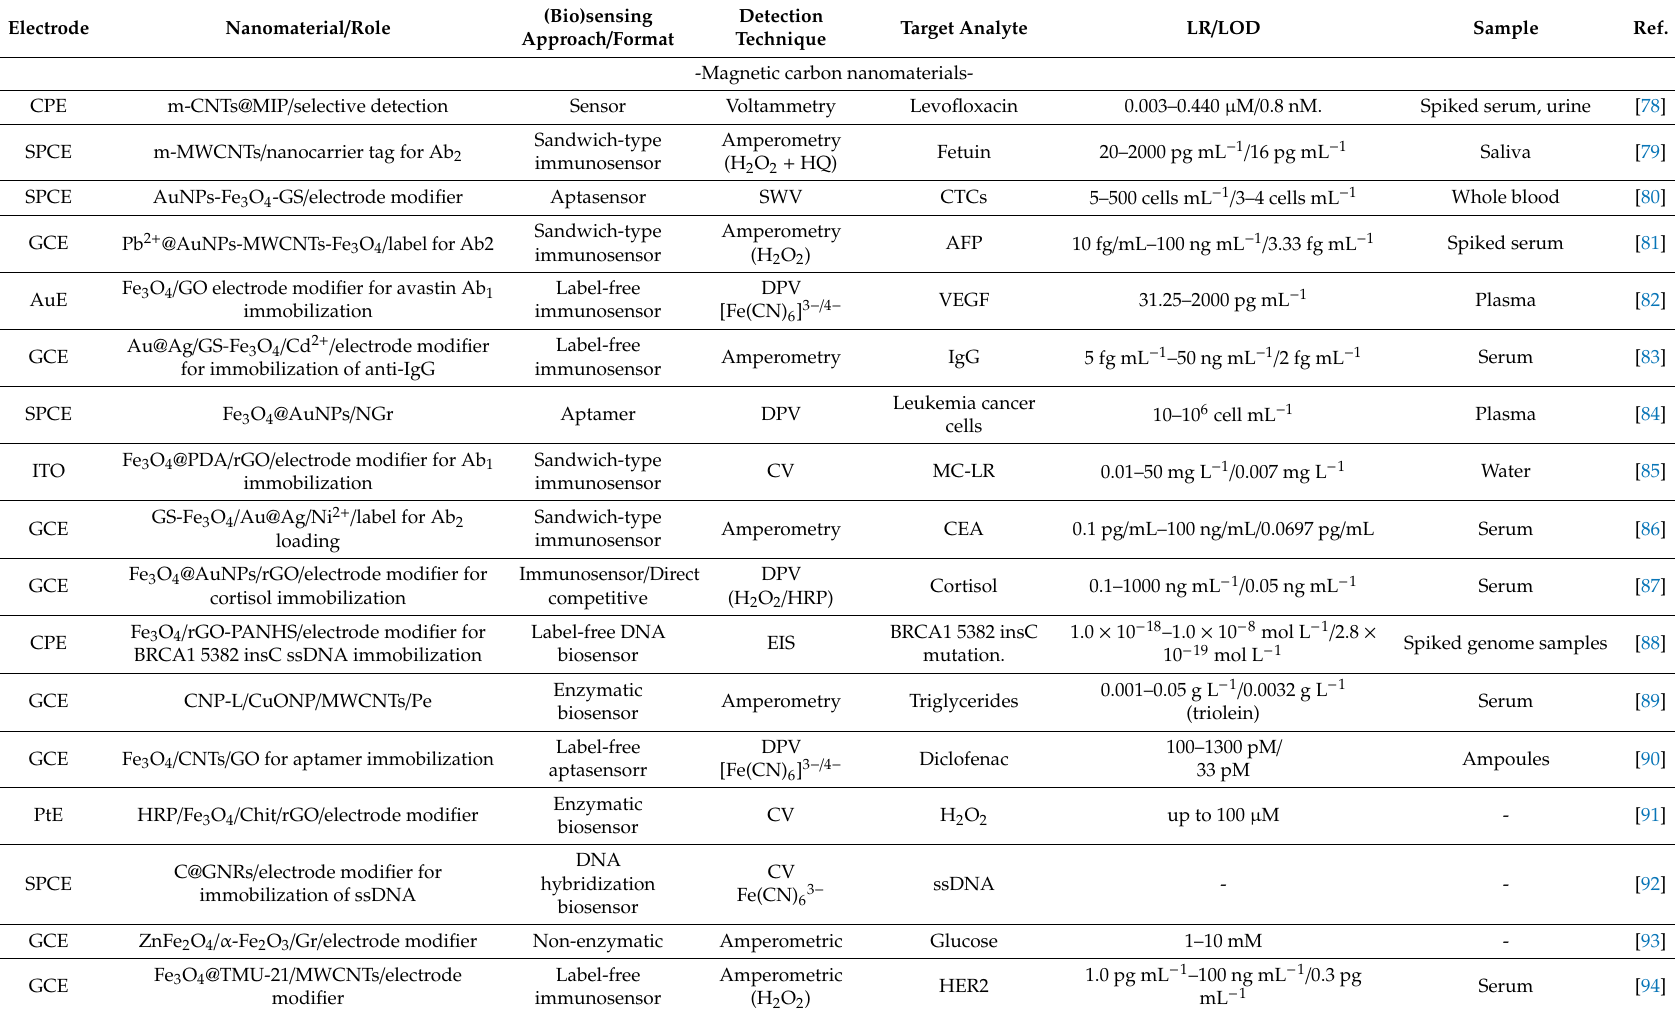
Table 2. Electrochemical (bio)sensing strategies involving multifunctional carbon